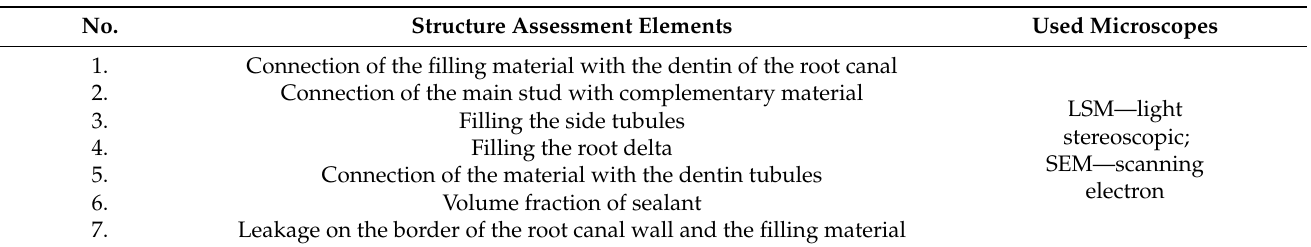
Table 5. Criteria for the evaluation of the research material depending on the variants of development and obturation of the root canal.